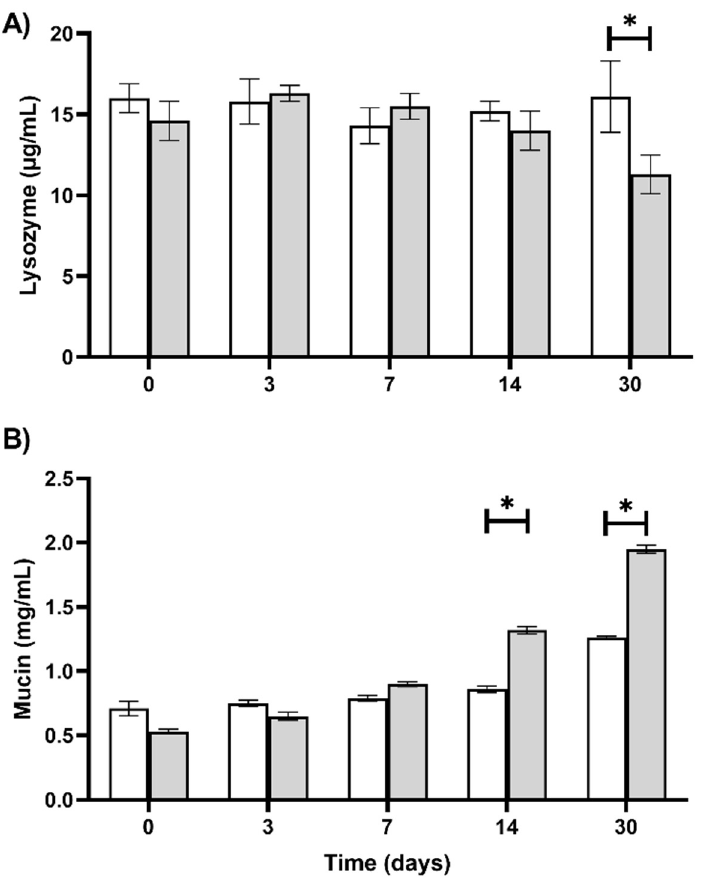
Figure 3. Lysozyme ( A ) and mucin ( B ) concentrations quantified in mucus of O. mykiss under LD24:0 photoperiod (grey bars) and controls (empty bars) during a period of 30 days. Asterisks indicate significant differences between treatments. Bars represent mean and ± Standard Error.